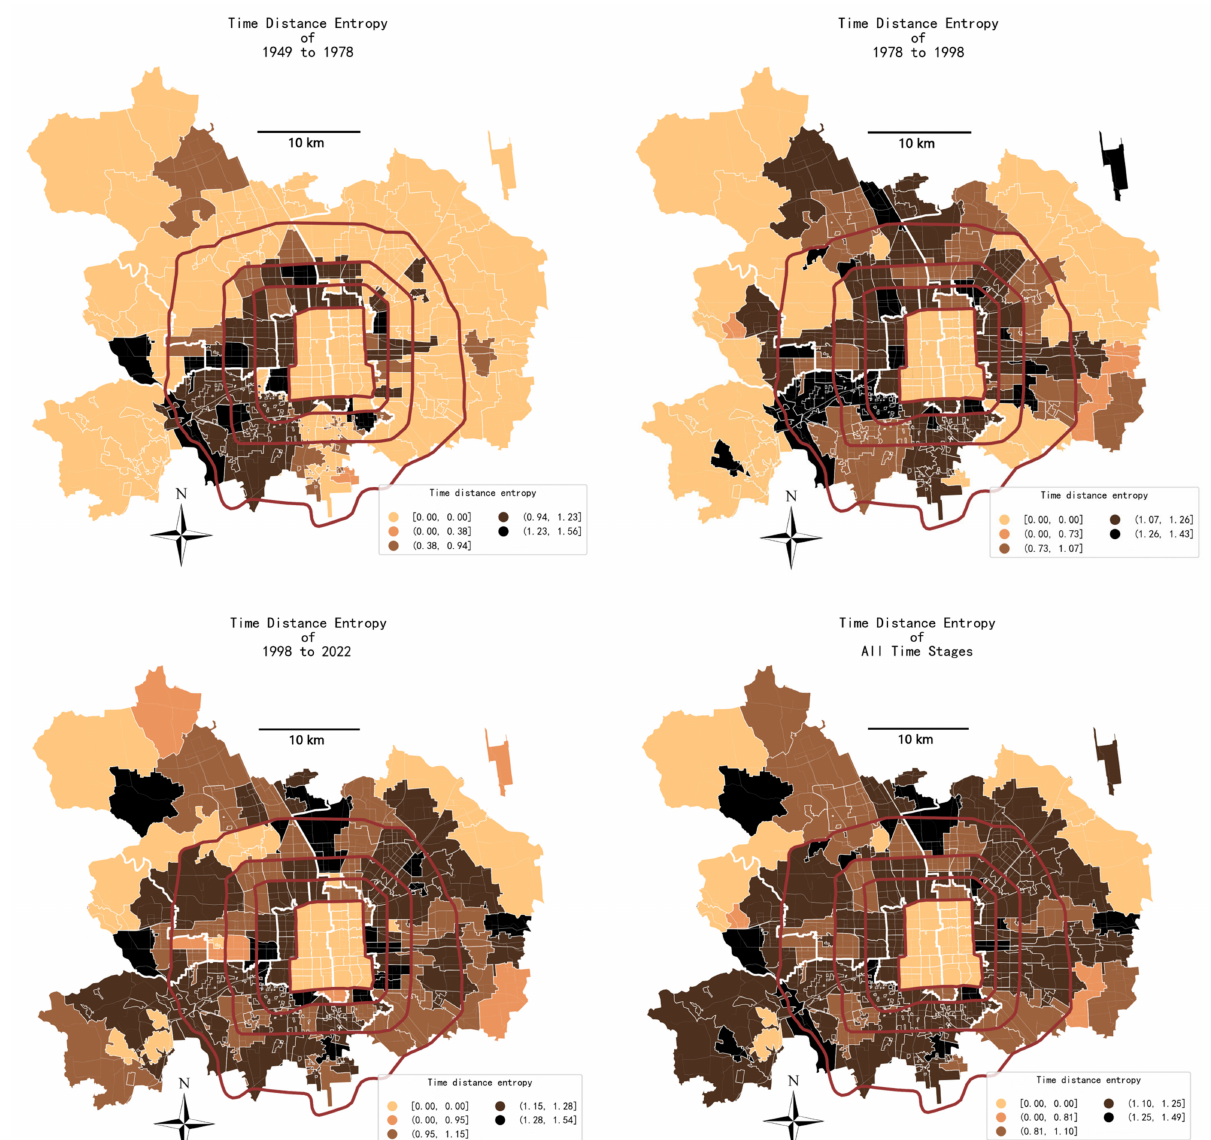
Figure 12. The spatial-temporal patterns of the Time Distance Entropy